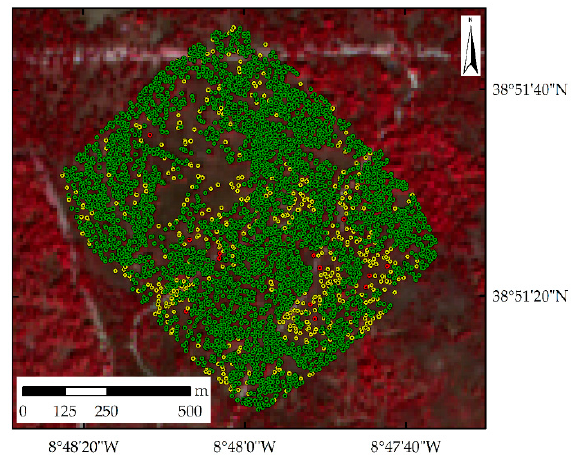
Figure 10. Results of the alert system for site CL (red circles represent diseased and/or dead trees, yellow circles represent suspicious trees and green circles represent healthy trees) superimposed to a S2 false-coloured composite.